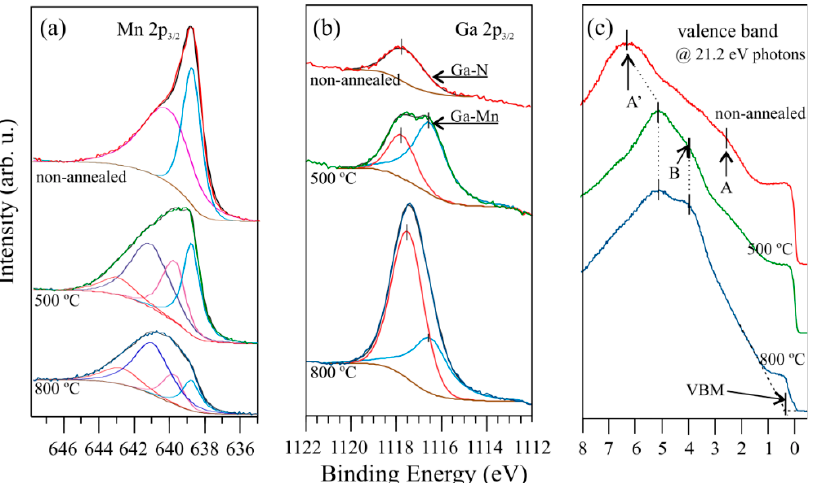
Figure 16. Evolution of spectra for ( a ) Mn-2p, ( b ) Ga-2d, and ( c ) valence band for Mn-film-covered GaN(0001) with annealing temperature. Data previously published in [23].